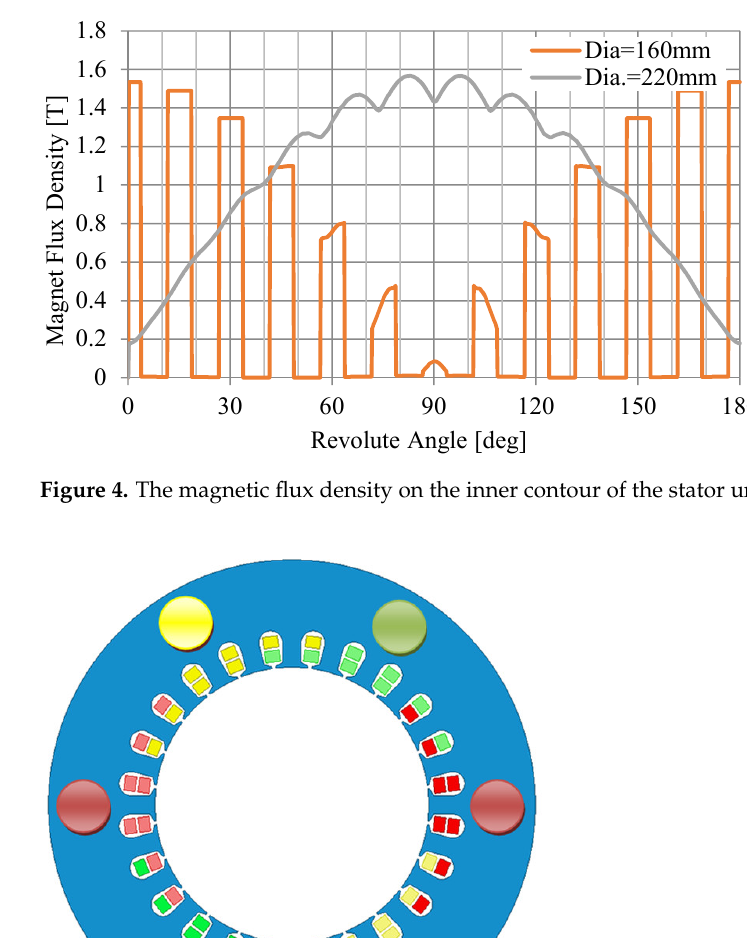
Figure 6. Cross-section of permanent magnet synchronous motor. The rotating shaft with permanent magnets generates electromotive force at the sta- tor coil terminals according to the rotation speed. The electromotive force increases with the increase in length, speed and magnetic flux density, as shown in Equation (2). (